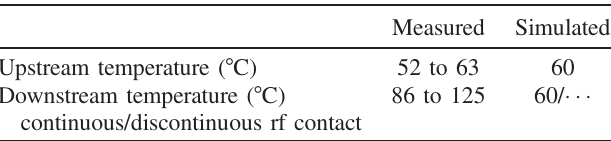
TABLE VI. Measured and simulated temperatures of the MIK chamber, at 500 mA, including forced air